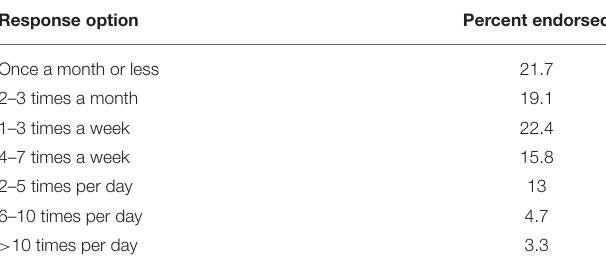
TABLE 3 | Endorsement rates for Duke Misophonia Questionnaire trigger frequency item. Response